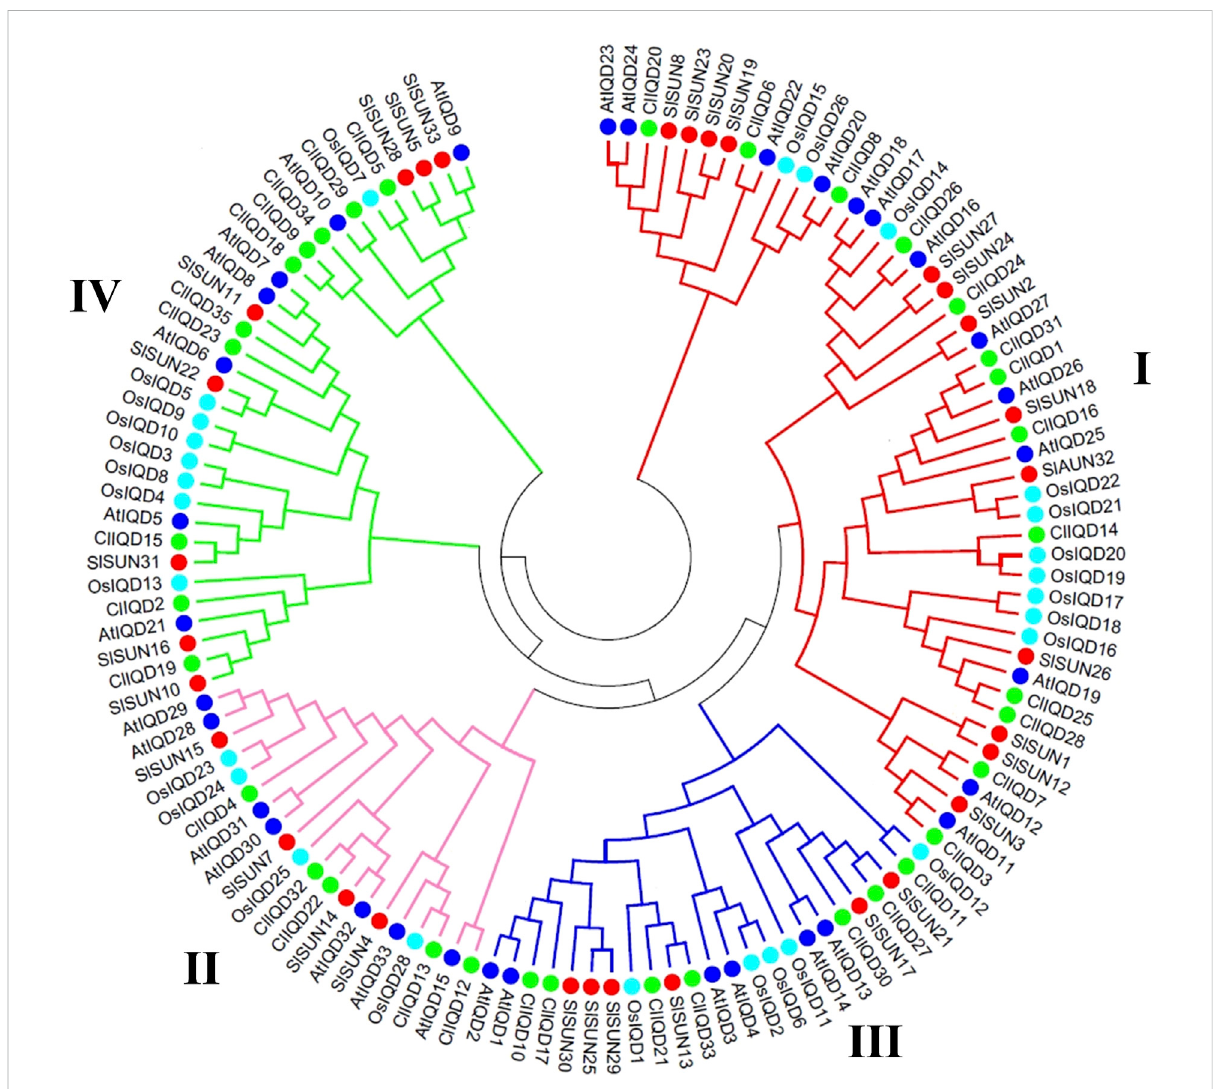
Phylogenetic relationships of Arabidopsis, rice, tomato, and watermelon IQD members. The full-length amino acid sequences of 129 IQD proteins were aligned using ClustalX 1.83. The phylogenetic tree was constructed using the neighbor-joining (NJ) method by MEGA 5.0. Each IQD class is indicated by the speci fi c line color. Redline, class I; Pink line, class II; Blue line, class III; Green line, class